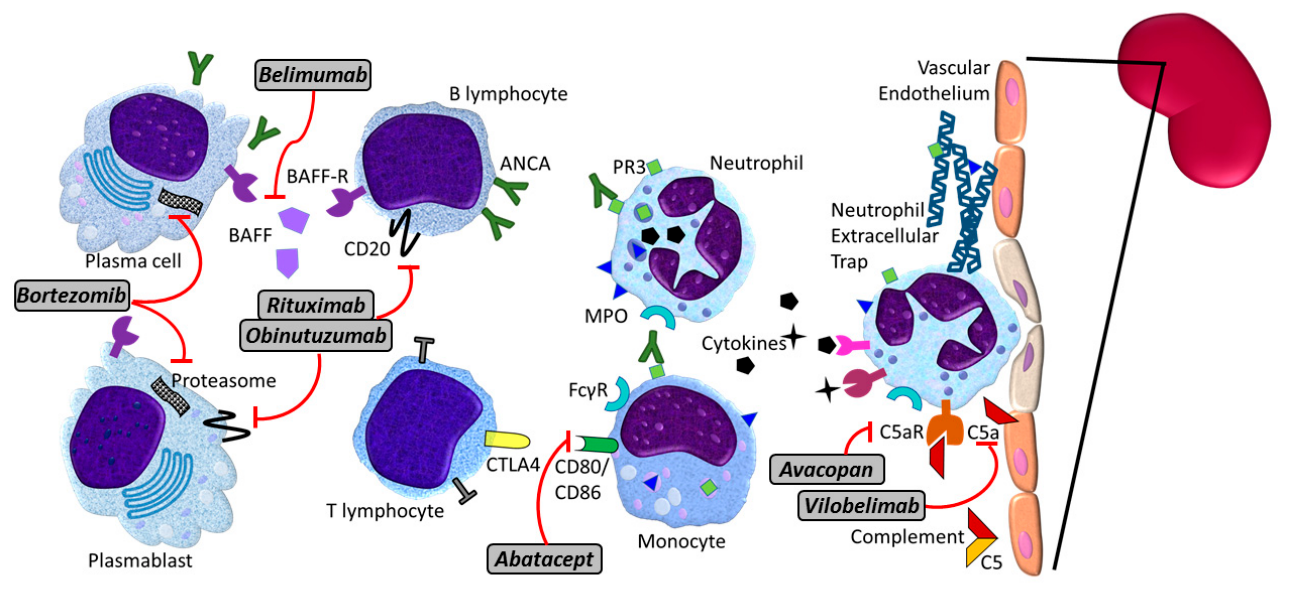
Figure 1. Pathogenesis of ANCA-associated vasculitis and potential targeted therapies. Pathogenesis of ANCA-associated vasculitis is multifactorial, involving numerous immune cells. B lymphocytes feature prominently as producers of ANCAs, with BAFF contributing to maintenance of autoreactive B cells, plasmablasts, and plasma cells. Neutrophils also feature prominently in the pathophysiology, driving much of the tissue damage via injury to the vascular endothelium. Complement factors, particularly C5a, and NETs are also important drivers of vascular inflammation and injury. From a therapeutic perspective, multiple targets have been identified for currently approved therapies and/or future directions, as treatment of ANCA-associated vasculitis becomes more precise and personalized, aiming to minimize the risks of therapy. Among those depicted, rituximab is the only currently approved therapy for ANCA-associated vasculitis, while the remainder represent therapies currently under investigation or potential therapeutic targets. Rituximab and obinutuzumab target CD20 which is expressed in B lymphocytes and plasmablasts. Bortezomib targets the proteasome and primarily target antibody-secreting plasma cells. By targeting BAFF, belimumab impacts the maintenance of autoreactive lymphocytes, plasmablasts, and plasma cells. Abatacept inhibits T-cell stimulation by antigen-presenting cells including B-cells. At the level of the vascular endothelium, vilobelimab and avacopan, target complement factor C5a and C5a receptor, respectively. Abbreviations: ANCA: anti-neutrophil cytoplasmic antibodies. BAFF: B lymphocyte activating factor. C5a: complement factor 5 fragment a. NETs: neutrophil extracellular traps. MPO: myeloperoxidase. PR3: leukocyte proteinase 3.